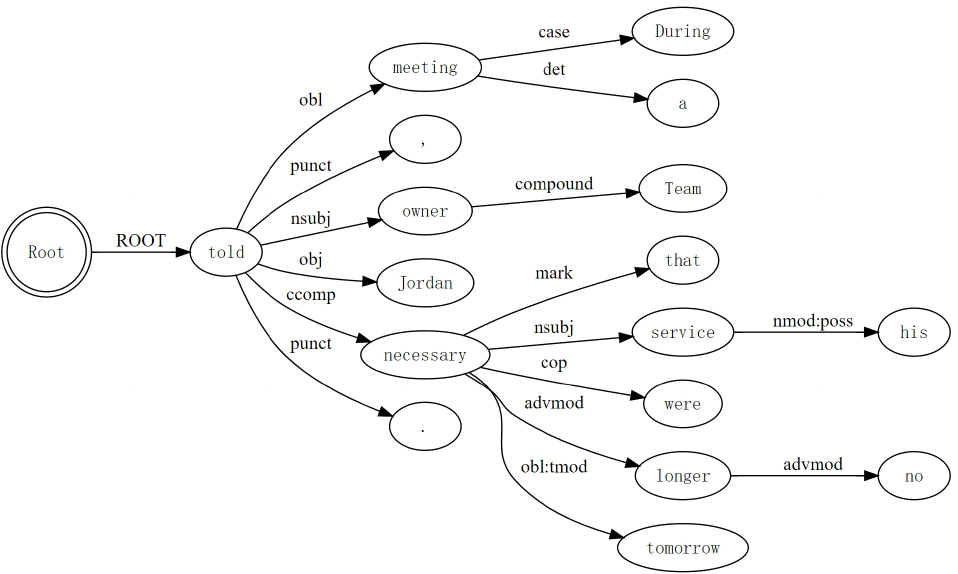
Figure 1. Dependency parsing results of the sentence “During a meeting, Team owner told Jordan that his service were no longer necessary